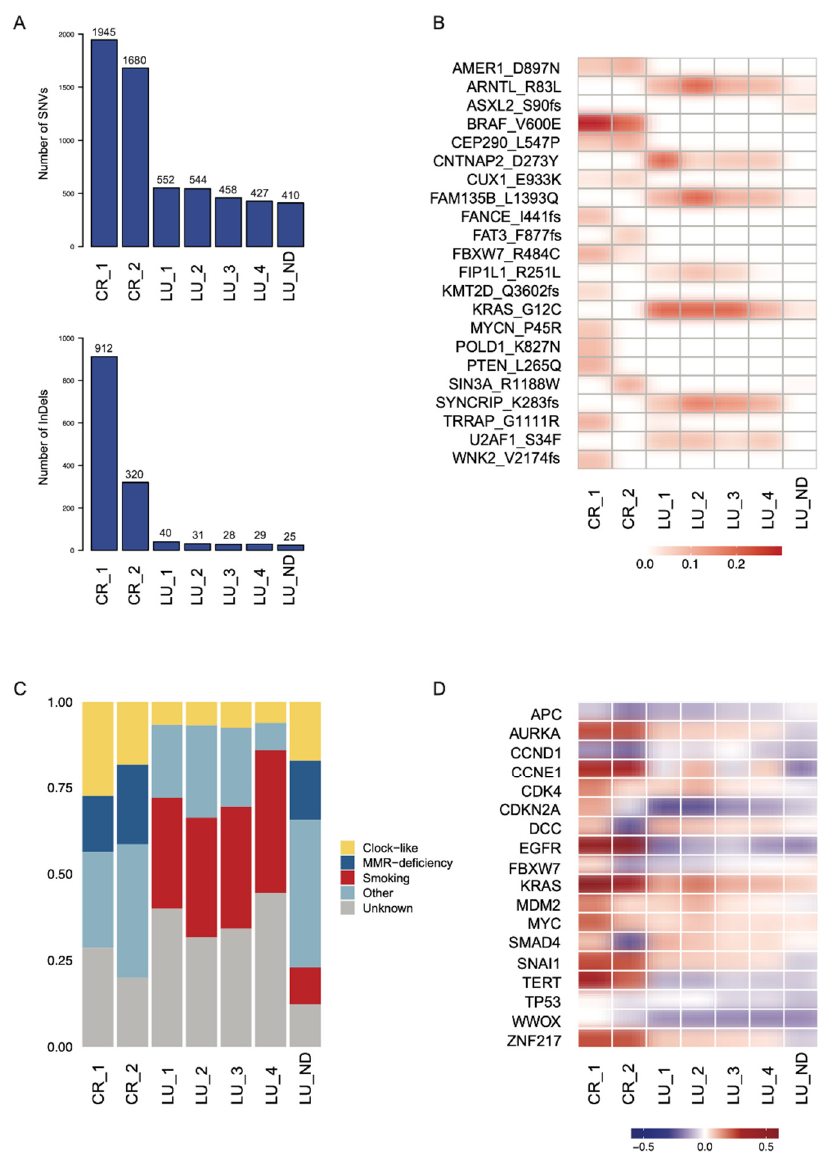
Figure 5. ( A ) Mutational burdens of SNVs and indels, quantified by whole-exome sequencing. ( B ) Variant allele frequencies of known and likely oncogenic mutations. ( C ) Tumour mutational profiles of total SNVs, defined by the weighted contributions of each input reference signature from COSMIC and identified by whole-exome sequencing. Signatures found in the samples include “clock-like” signatures (SBS1 and SBS5), “MMR-deficiency”-related signatures (SBS15, SBS21, and SBS26), the “smoking” signature (SBS4), and “other” signatures (SBS10b, SBS12, SBS16, SBS24, SBS27, SBS37, SBS49, and SBS50). ( D ) Median log-ratios of putative driver CNAs. Positive log-ratios (gains) are represented in red and negative log-ratios (losses) are represented in blue.